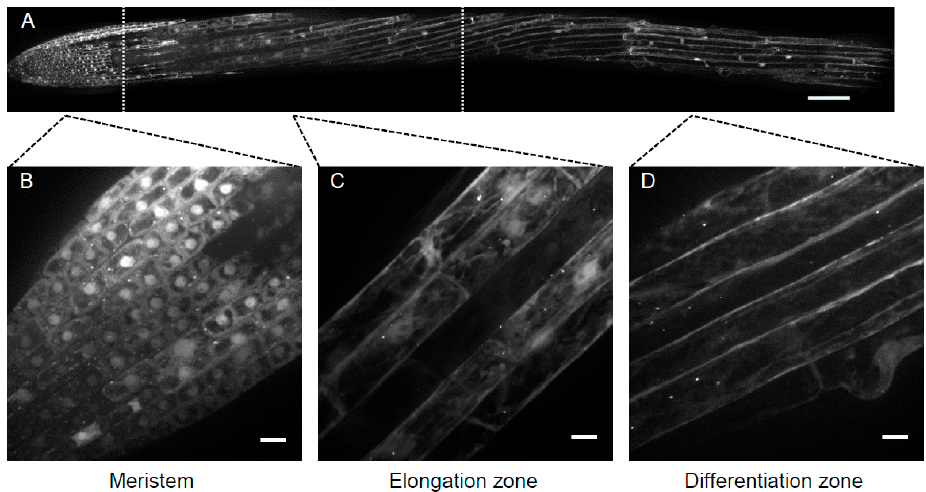
Figure 2. ( A – D ) Longitudinal distribution of the autophagy marker ATG8 linked to the green fluorescent protein (GFP) in Arabidopsis in the elongation zone ( C ) and differentiation zone ( D ). Images represent maximum intensity root (see Sections 5 and 7). ( A ) Expression of GFP-ATG8f in 5-day-old Arabidopsis root in the whole root ( A ), corresponding to three distinct physiological zones (separated by dotted lines), and zoomed in ( B – D ): note the ATG8-labeled fluorescent structures in the meristematic zone ( B ) but the low level of expression projection (MIP) of a Z-stack within 60 µm of tissue thickness. Scale bar: ( A ) 100 µm; ( B – D ) 10 µm.